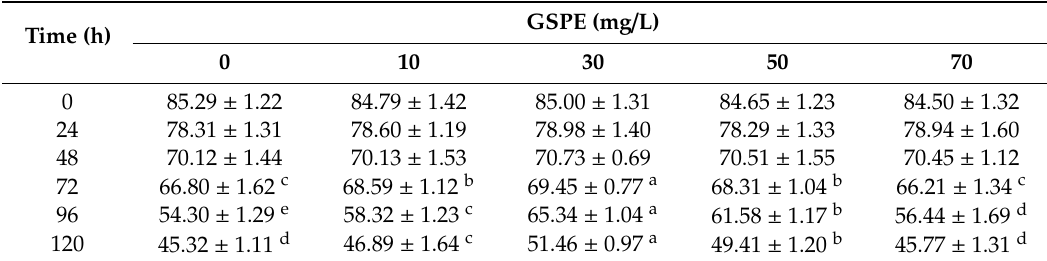
Table 1. E ff ect of grape seed procyanidin extracts (GSPE) on the motility of goat sperm of preserved at 4 ◦ C